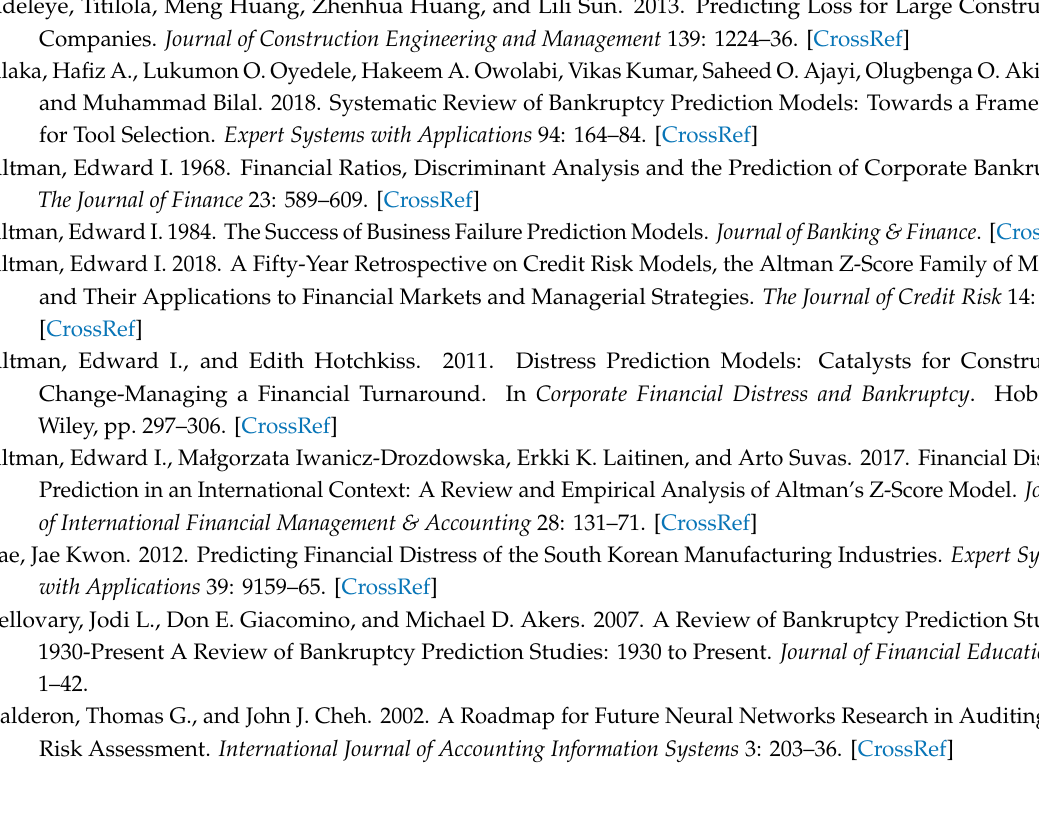
Supplementary Materials: The data for the regression count citation model calculation are available online at doi:10.17632 /